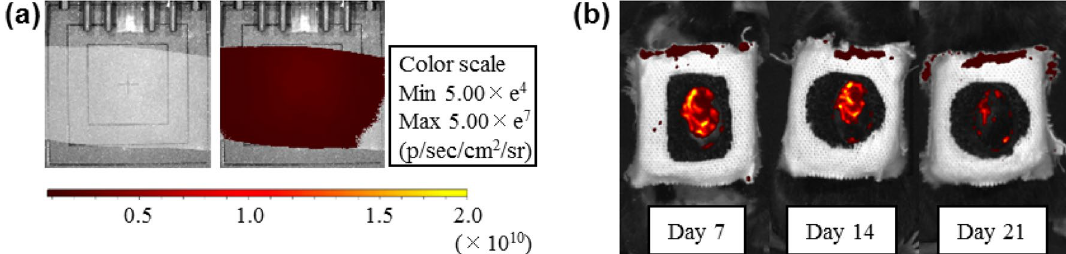
Figure 4. IVIS image of Nile Red nanosheet. ( a ) A nanosheet containing Nile Red was made to observe transition of the adhesion state of the nanosheet on the wound. ( a ) Left : bright field image of the Nile Red nanosheet, ( a ) right : fluorescence image of the Nile Red nanosheet (Exitation filter 560 nm, Emmision Filter 620 nm). ( b ) Images of fluorescence from the Nile Red nanosheet implanted onto the wound of a mouse on days 7, 14, and 21 after implantation (representative images). More than 40% of the nanosheet remained even on day 14. About 90% of the nanosheet had disappeared on day 21.